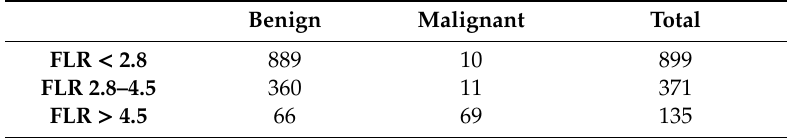
Table 6. Semiquantitative real-time elastography scores and malignancies (1405 nodules).